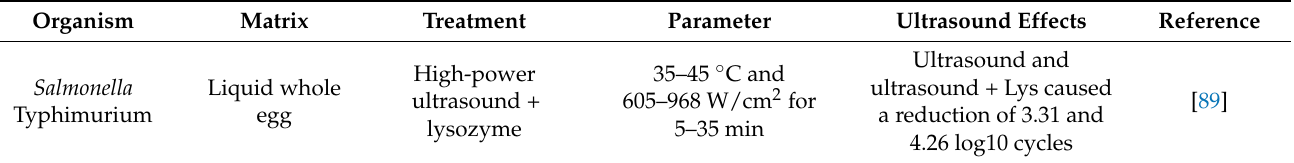
Table 3. Ultrasound effects as individual or combined non-thermal technology: Salmonella